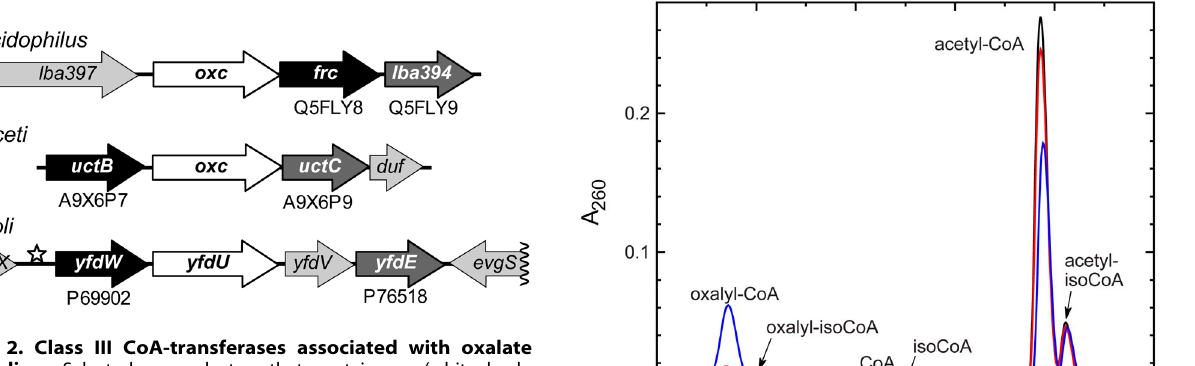
Figure 2. Class III CoA-transferases associated with oxalate metabolism. Selected gene clusters that contain oxc (white back- grounds) and two class III CoA-transferase genes. CoA-transferase gene names are shown in white: black backgrounds, FCOCT subgroup; medium-gray backgrounds, ACOCT subgroup. UniProt accession numbers are given for each CoA-transferase. Unrelated proteins have light gray backgrounds; flanking proteins on the opposite DNA strands are not shown, except for the 3 0 end of the E. coli evgS gene, the sensor kinase of the EvgAS two-component response regulator [14]. Stars indicate the locations of inverted repeats to which EvgA binds, inducing the expression of yfdX and yfdWUVE [15].